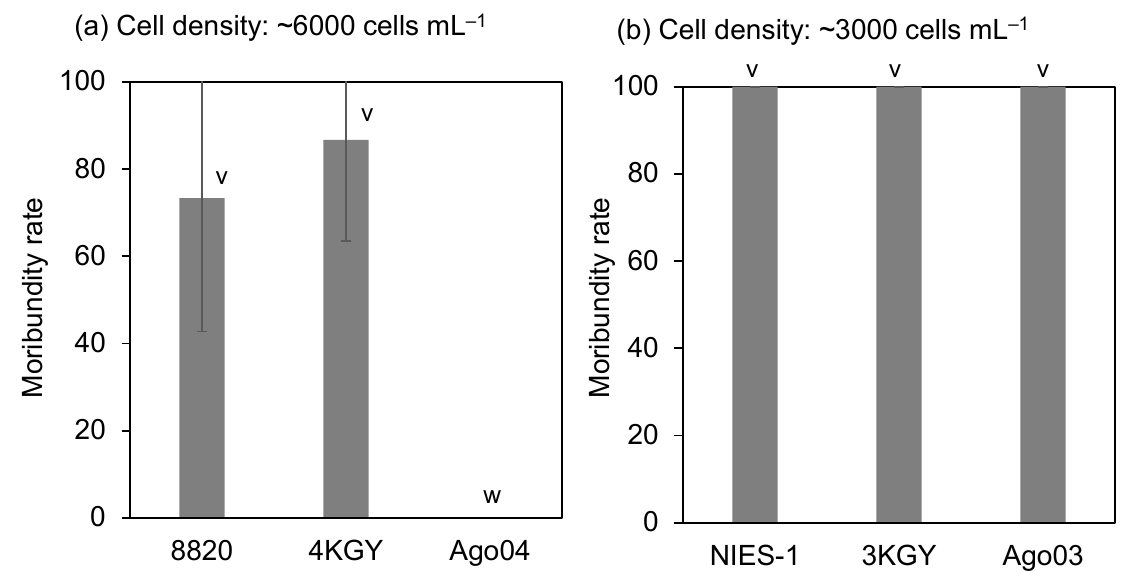
Figure 3. Toxicity of Chattonella strains to yellowtail at different cell densities. Each bar represents the mean ± SD of triplicate measurements. Low-toxicity strains (8820, 4KGY, Ago04) ( a ) and highly toxic strains (NIES-1, 3KGY, Ago03) ( b ) were exposed to fish at cell densities of ~6000 and ~3000 cells mL − 1 , respectively. Means that are not significantly different are labeled with the same letter (v or w; p < 0.05).